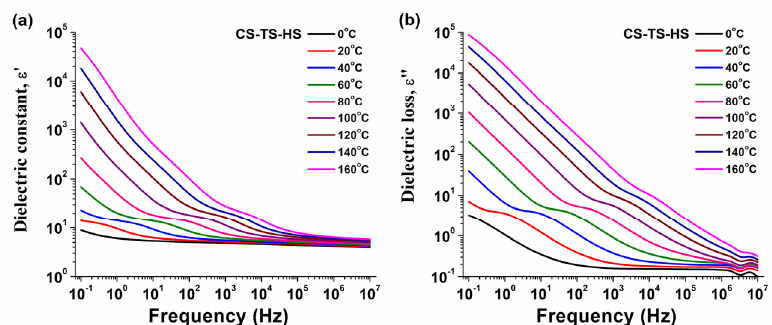
Figure 6. Evolution of the dielectric constant ( a ) and of the dielectric loss with frequency ( b ) for dry CS-TS-HS composite membrane.